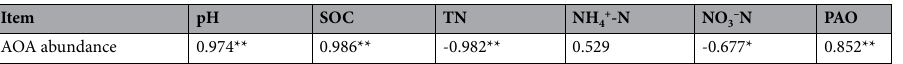
Table 4. Correlation coefficients between soil properties and the abundance of soil ammonia-oxidizing archaea (AOA). SOC: soil organic carbon; N: nitrogen;TN: total N; NO 3- —N: nitrate N; NH 4+ —N: ammonium